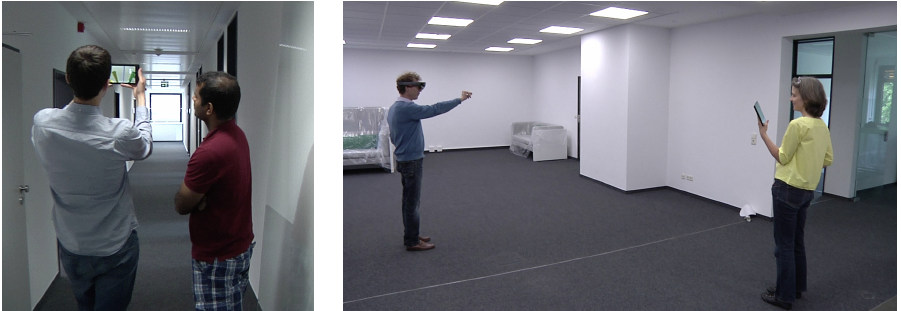
Figure 3. Two teams discussing with the help of a Tango tablet ( left ) and with the help of a HoloLens and a Surface tablet ( right